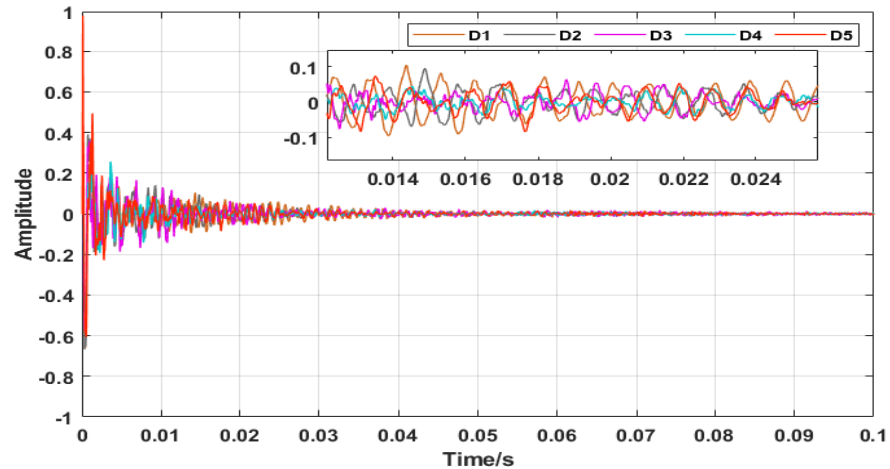
Figure 5. Samples of sound signals taken for five damage degrees.